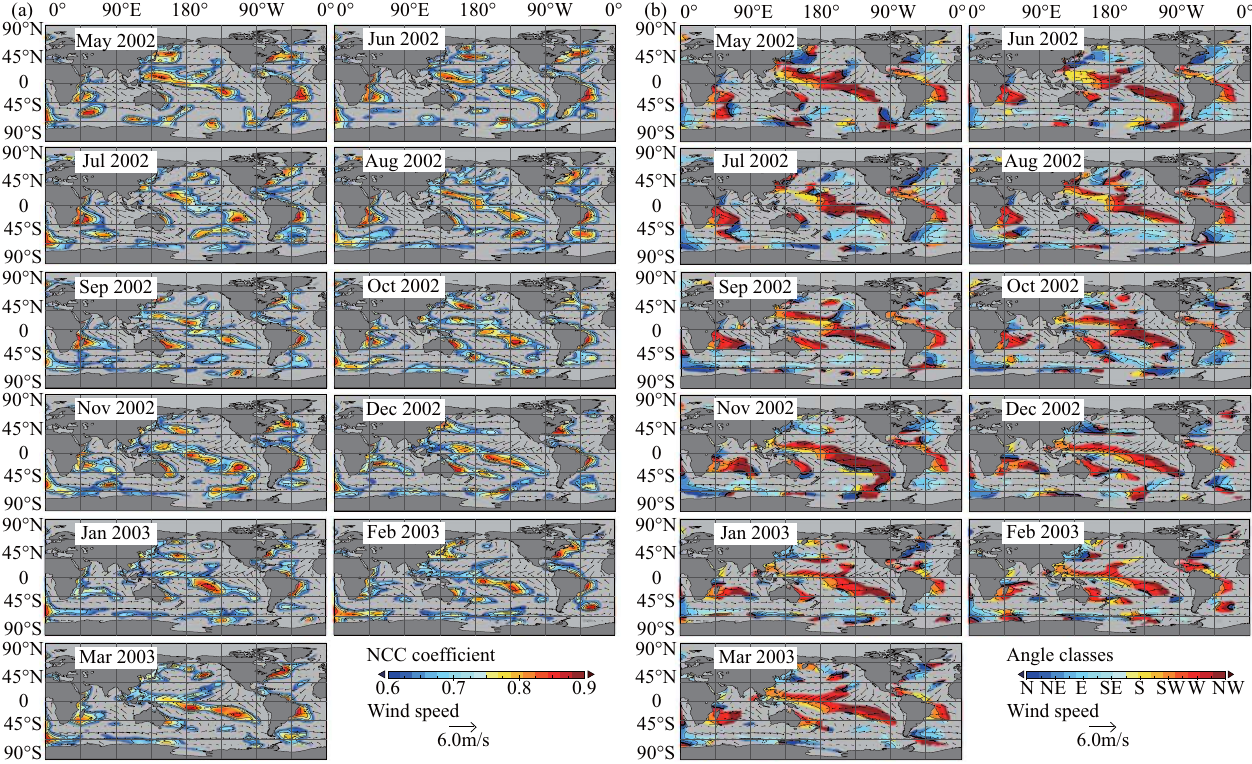
Fig. 5. The filtered results of modified correlation product with NCC > 0.6 during May 2002 to March 2003. (a) is the NCC filtering results, and (b) is the direction classification filtering results.